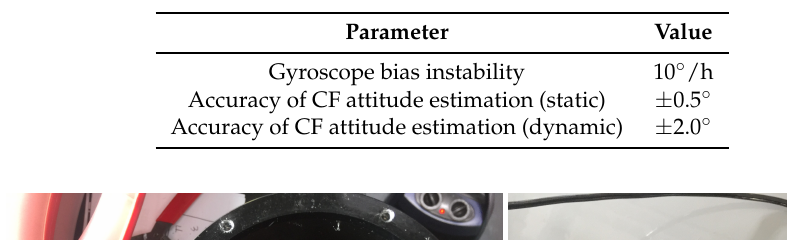
Table 2. Specification of AHRS used in experiment 1.